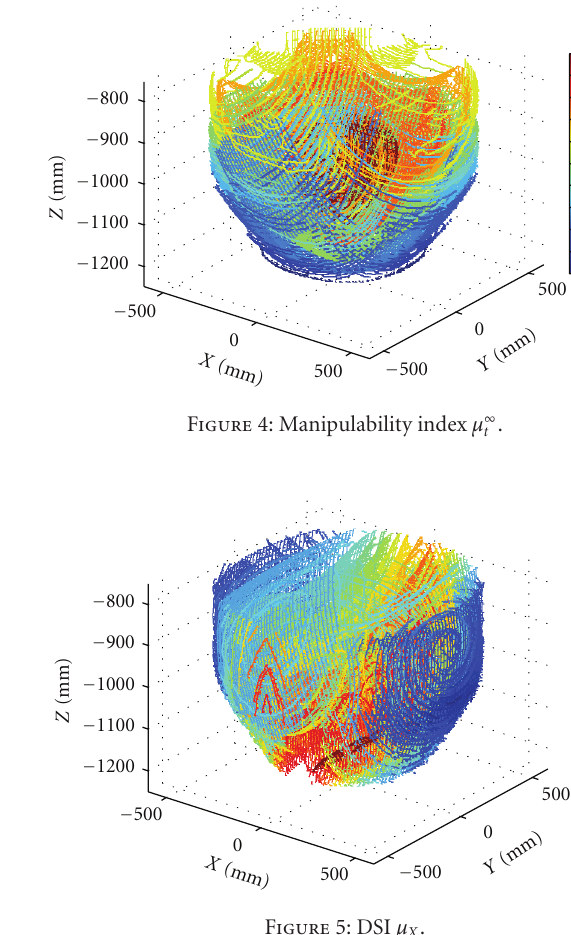
Figure 3: Manipulability index μ F t .